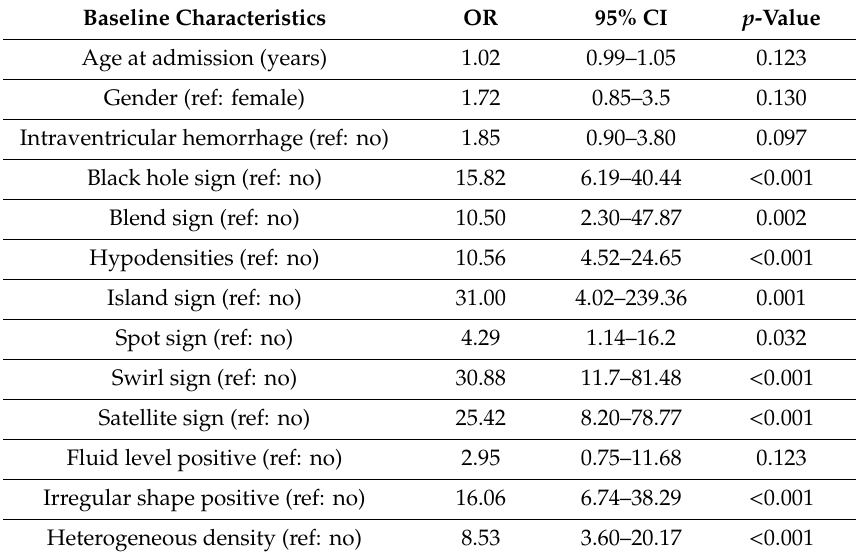
Table 3. Univariable analysis of predictors of poor outcome.